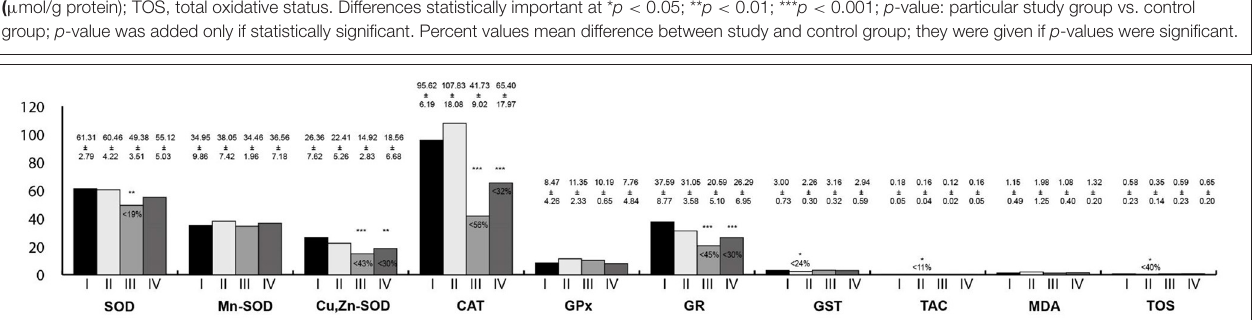
FIGURE 4 | Oxidative stress parameters in the stomach homogenates. I, control group; II, group exposed to LF-EMFs; III, group exposed to RF-RMF; IV, group exposed simultaneously to LF-EMFs and RF-EMFs; SOD, superoxide dismutase (NU/mg protein); Mn-SOD, manganese-dependent superoxide dismutase (NU/mg protein); Cu,Zn-SOD, copper- and zinc-dependent superoxide dismutase (NU/mg protein); CAT, catalase (IU/g protein); GPx, glutathione peroxidase (IU/g protein); GR, glutathione reductase (IU/g protein); GST, glutathione S-transferase (IU/g protein); TAC, total antioxidant capacity (mmol/g protein); MDA, malondialdehyde ( µ mol/g protein); TOS, total oxidative status. Differences statistically important at * p < 0.05; ** p < 0.01; *** p < 0.001; p -value: particular study group vs. control group; p -value was added only if statistically significant. Percent values mean difference between study and control group; they were given if p -values were significant.